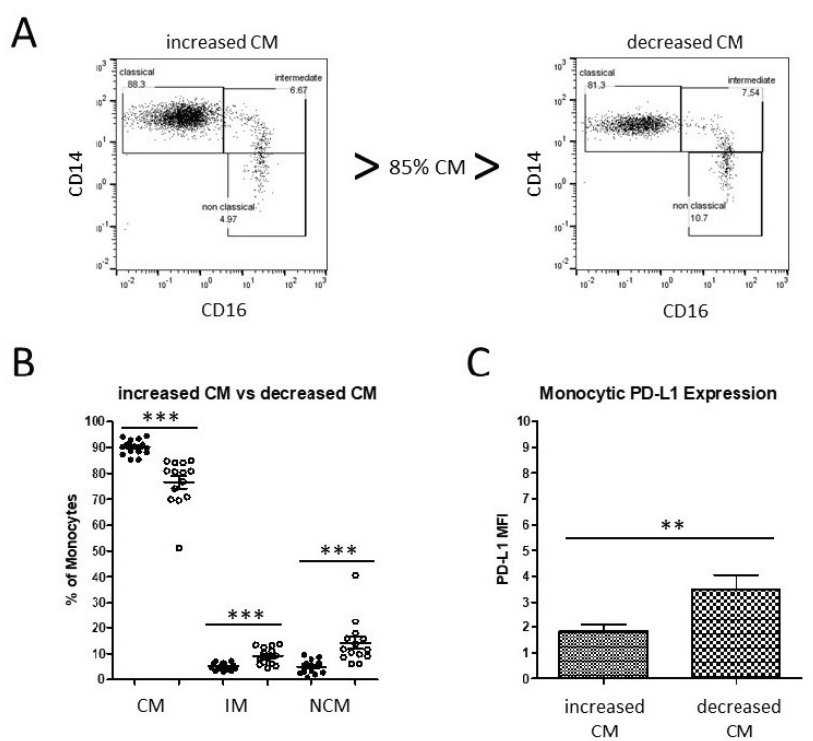
Figure 2. Flow cytometric analysis of two distinct OPC patient cohorts. ( A ) Analyses of two representative patients with increased and decreased abundances of peripheral classical monocytes. ( B ) OPC patients with decreased classical monocytes revealed significantly increased levels of both intermediate and nonclassical monocytes. ( C ) OPC patients with decreased classical monocytes revealed significantly increased expression levels of monocytic PD-L1. ** p < 0.01; *** p < 0.001.